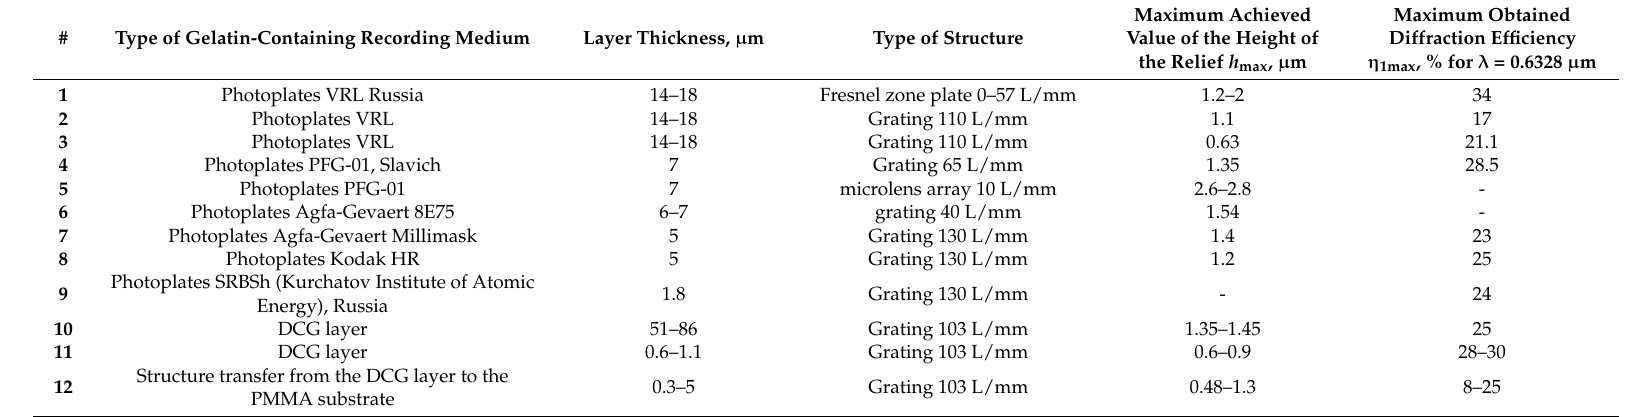
Table 1. Parameters of the regular holographic structures on silver halide photoemulsions and